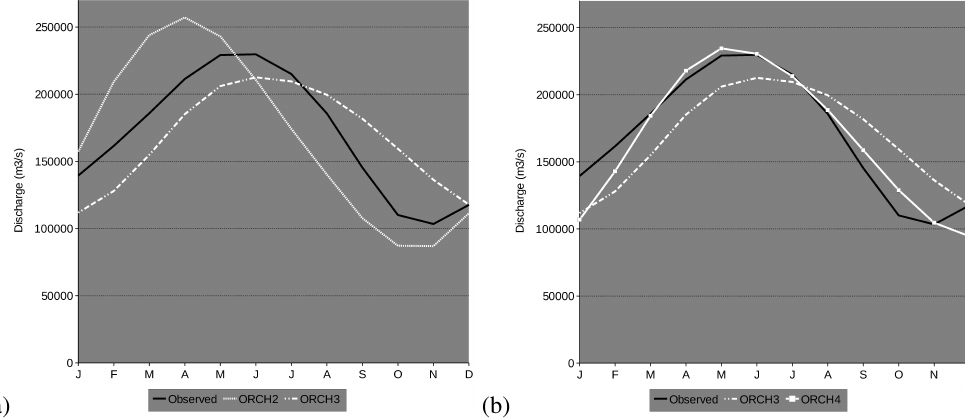
Fig. 14. Mean monthly seasonal discharge (m 3 s − 1 ) at ´Obidos for simulation ORCH3 compared to (a) ORCH2 and (b) ORCH4. Comparison with observations is shown over the mean time period 1980–2000.